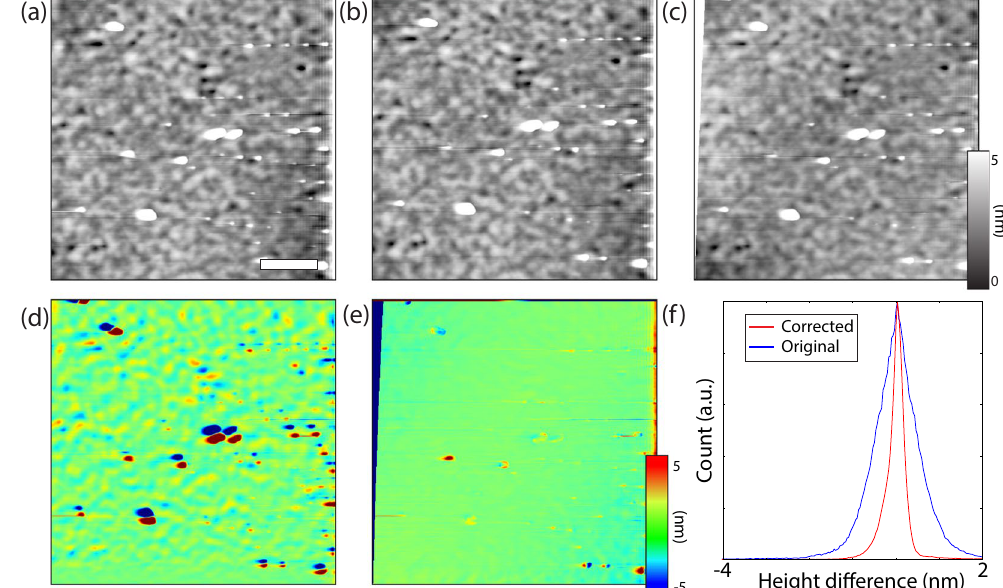
Figure 1. ( a , b ) Subsequent topographic images acquired on a PZT thin film, with the white scale bar representing 1 μ m. ( d ) The height difference between the uncorrected images demonstrates that the two images cannot be directly correlated spatially. The corrected image ( c ), however, shows a substantially lower variation in the height difference ( e ), demonstrating the effectiveness of the algorithm. This is further substantiated by the collapse of the histogram of height differences ( f ), with the corrected histogram having a narrower distribution around 0